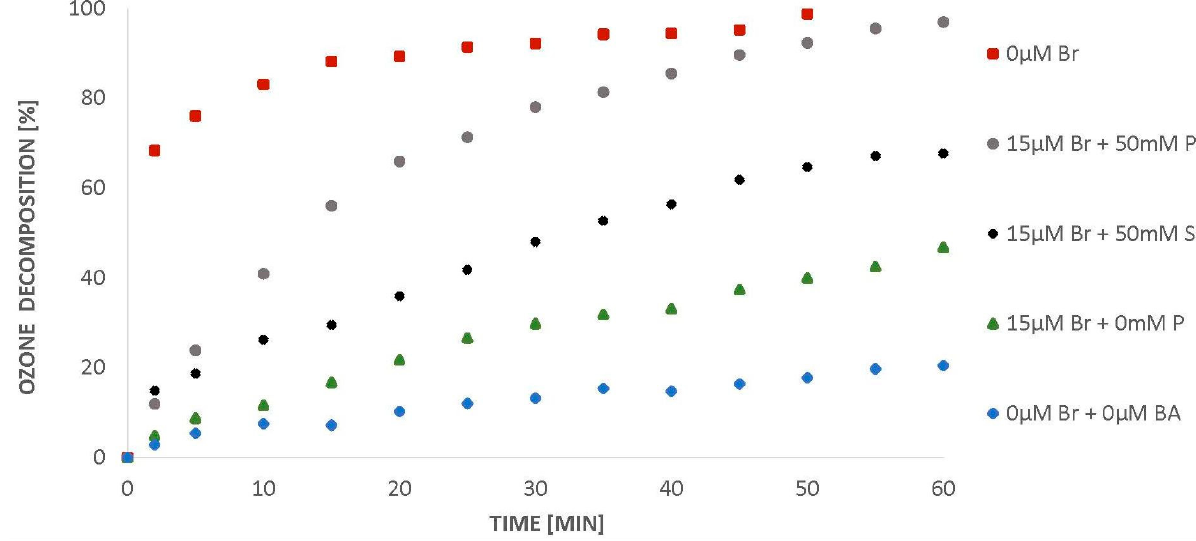
Figure 7. Ozone decomposition in the presence of BA (24 µM), bromides (0 and 15 µM) and 50 mM sulphates (S) or phosphates (P), pH = 2.5.